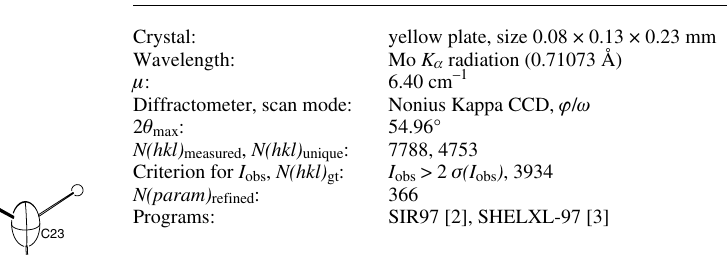
Table 1. Data collection and handling.